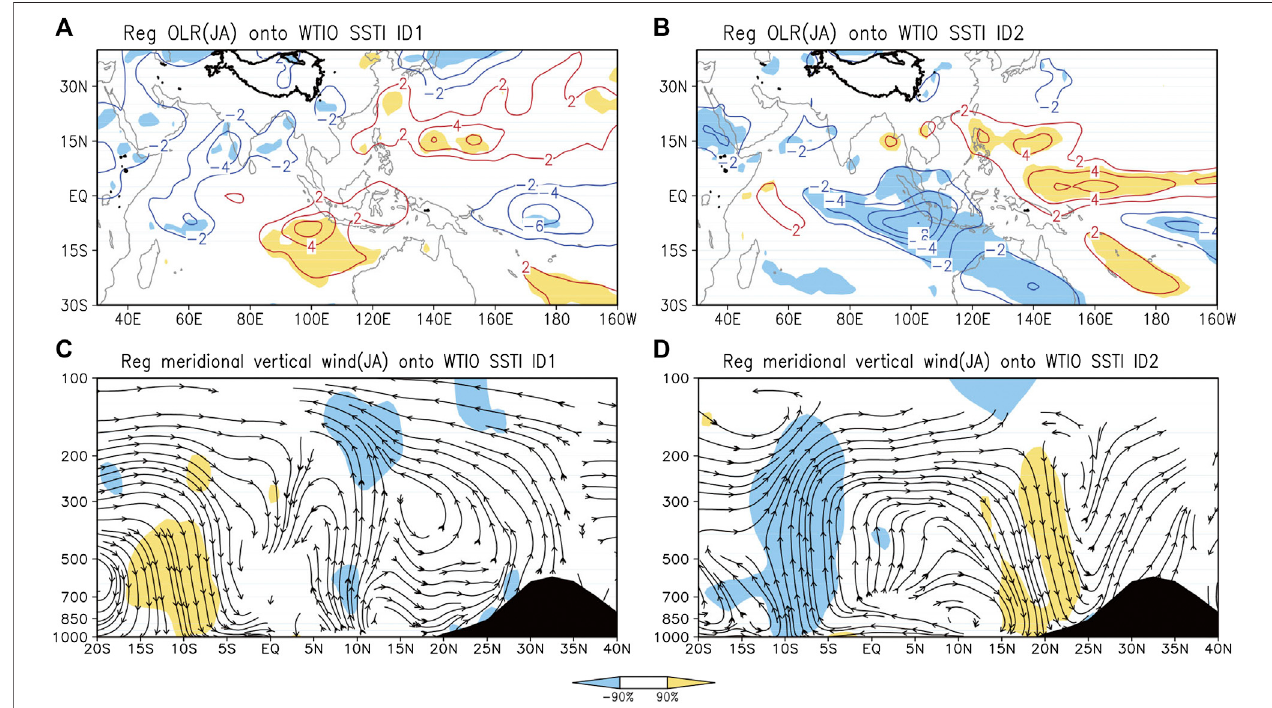
FIGURE 9 | Same as Figure 5 but for summer (A,B) OLR (contour, W · m − 2 ) and (C,D) meridional (m · s − 1 ) vertical (0.01 hPa · s − 1 ) wind (vector) averaged over 90 ° – 110 ° E in (A,C) ID1 and (B,D) ID2. Areas that are signi fi cant at 90% con fi dence level are